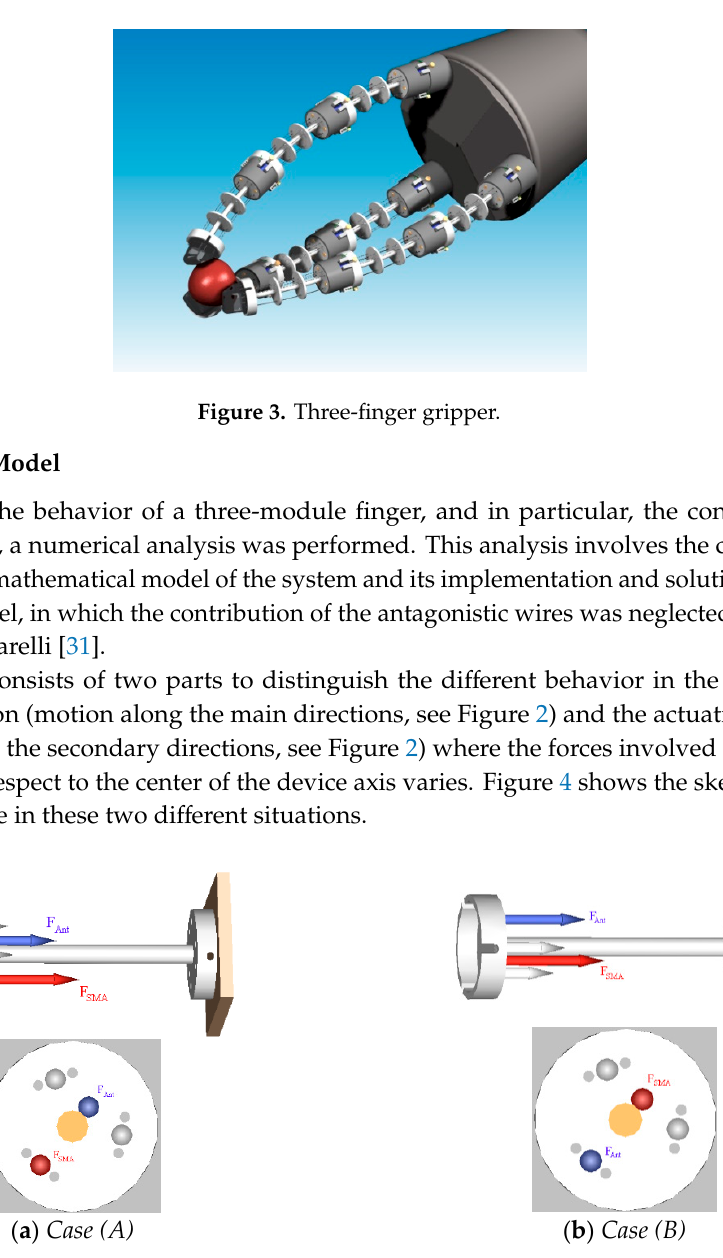
Figure 4. Sketch of the forces acting on a module: ( a ) lateral view and plant view in the case of one-wire activation (A), ( b ) lateral view and plant view in the case of two-wire activation (B).